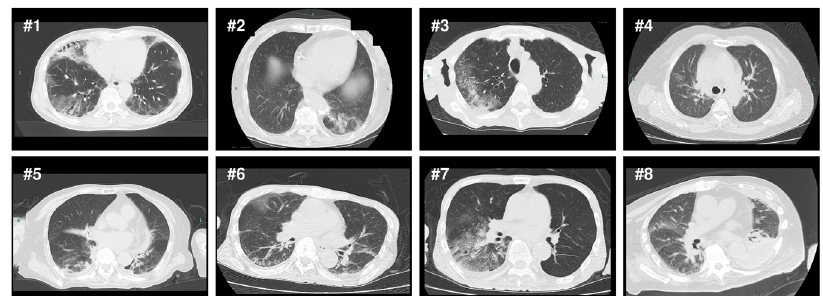
Fig. 4 Eight fully vaccinated patients showing signs of pneumonia after BA.2 infection. Chest CT images of the eight fully vaccinated cases who shows COVID-19 pneumoniae. These CT scans were taken immediately upon admission to the hospital.